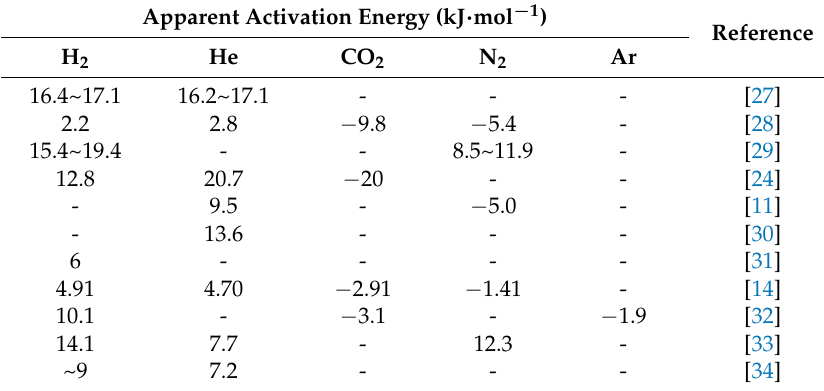
Table 1. Apparent activation energies of gas permeation across silica based